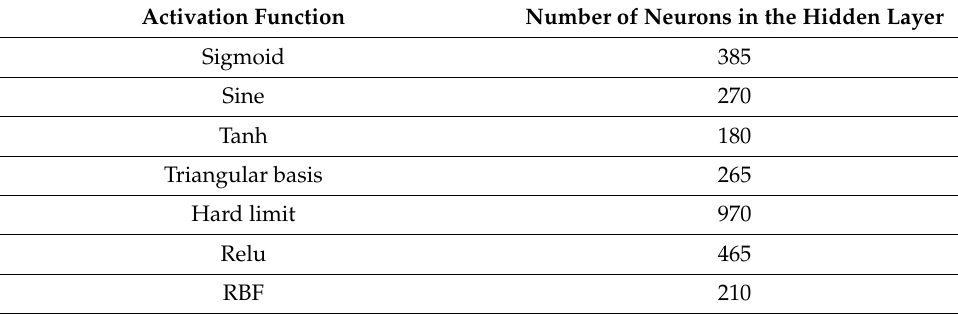
Table A3. Optimal hidden neurons for developing ELM